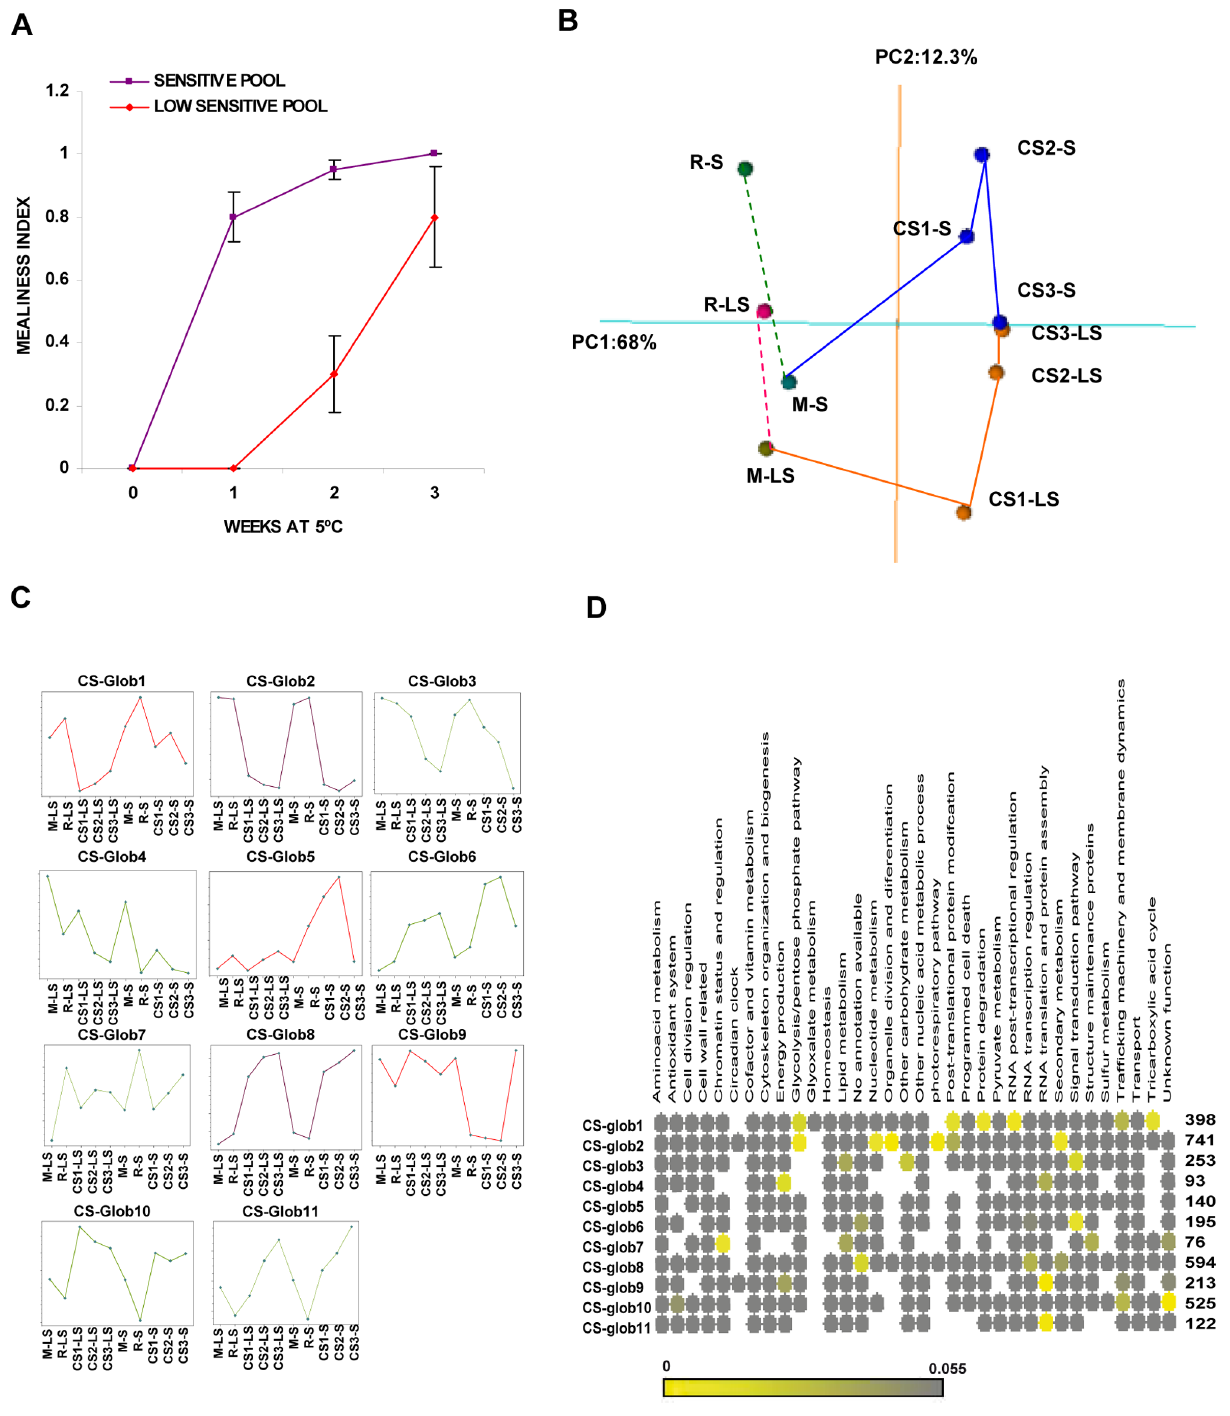
Figure 1. Mealiness index of pools of peach Pop-DG siblings and global gene expression analysis of Chillpeach transcripts in response to cold storage. A) Average mealiness index (MI) of pools S and LS from fruits shelf life ripened for 2–3 days at 20 u C after being stored for up to 3 weeks at 5 u C; B) Principal Component Analysis (PCA) of the global expression profile showing the most variation of each treatment condition (averaged from three replicates). First principal component (PC1) is shown on x-axis while the second principal component (PC2) is shown on y-axis. C) Clusters resulting from the unsupervised two-dimensional hierarchical clustering (Fig. S2). Y-axes represent the normalized expression ratio (Log2 M) of three biological replicates in relation to a reference pool. Red represents qualitative differences, purple depicts the genes regulated in a similar manner and green refers to the genes showing quantitative differences between the LS and S pools. D) The functional categories overrepresented in each cluster (Fig. 1C) are shown as a heatmap obtained with matrix2png. Enriched functional categories with Fisher test p-values , 0.05 are colored in grades of yellow. The number of genes in each cluster is indicated to the right of the heatmap. M=mature fruits, R=mature with 2–4 days ripening at 20 u C, CS1=M + 1 week cold storage at 5 u C, CS2=M + 2 weeks cold storage at 5 u C, CS3=M + 3 weeks cold storage at 5 u C.